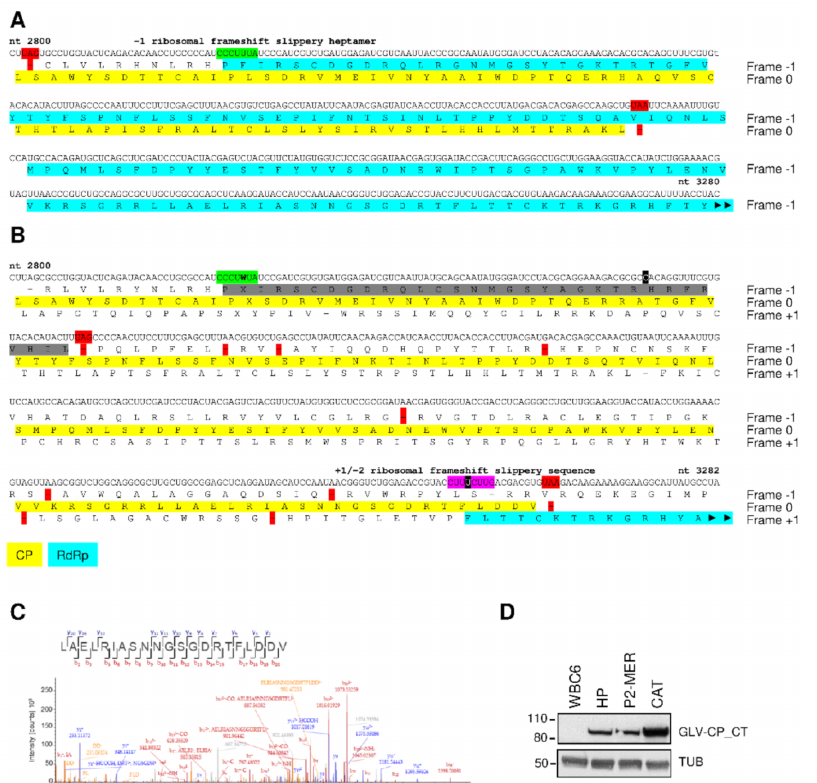
Figure 3. Effect of nucleotide insertions in GLVs on CP sequences and frameshifting mechanism. ( A , B ) Overlapping portion of CP and RdRp ORFs and corresponding amino acid sequences in the reference GLV strain L13218 ( A ) and GLVHP ( B ). Nucleotide insertion are in white. Slippery sequences are highlighted: green, originally proposed slippery sequence for the -1 PRF is in green [21]; pink, alternative slippery sequence for the +1/-2 PRF. Stop codons are in red, CP protein sequence is yellow highlighted. ( C ) Mass spectrometry analysis of the GLV CP C-terminus. MS/MS spectrum of the triple charged CP-HP peptide (911–931) derived from digestion with chymotrypsin. The ion at m / z 755.38 was fragmented and b- and y-series ions are shown in red and blue, respectively. Neutral losses from the precursor ion are shown as green peaks and internal fragments are reported in yellow. The sequence of the peptide matching the fragments detected in the MS/MS spectrum is reported in the panel: the dark lines define the fragments of the b- or y-series ion detected in the MS/MS spectrum. ( D ) Confirmation by immunoblot of the C-terminus of the GLV capsid protein (GLV-CP). Western blot analysis of protein extracts (50 µ g) from trophozoites of G. duodenalis isolates harboring the viruses (HP, CAT and P2-MER or from control naïve isolate (WBC6). Immunoblotting was performed with mouse anti-GLV-capsid protein C-terminal pAb (GLV-CP_CT). The anti- α -tubulin (TUB) was used as loading control. Molecular size markers (kDa) are reported on the left. The analysis is representative of three independent